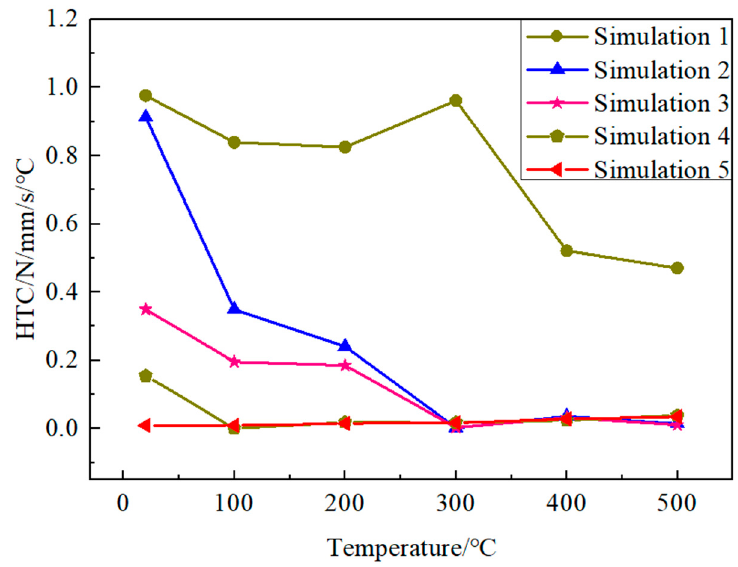
Figure 7. The heat transfer coefficient curve in the heating process.